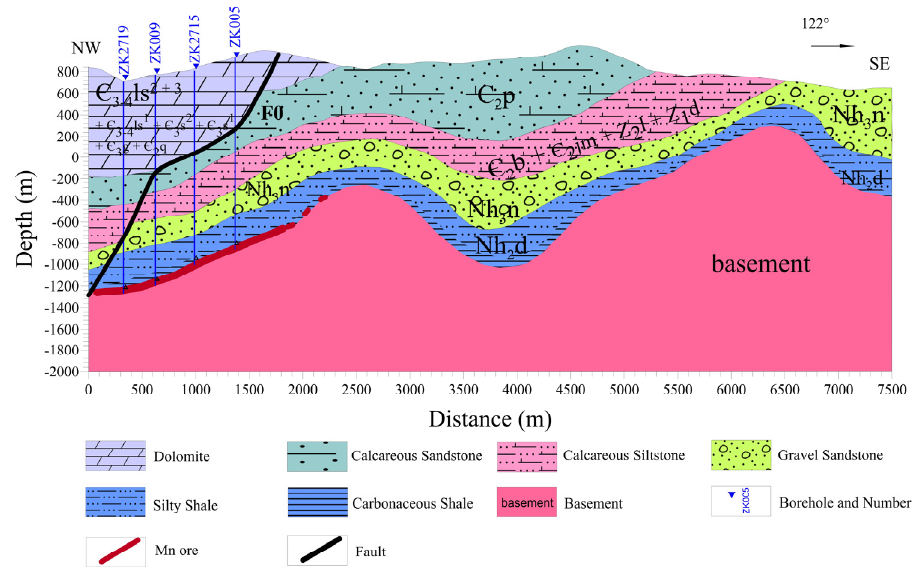
Figure 7. The geological section with resistivity model and four boreholes.